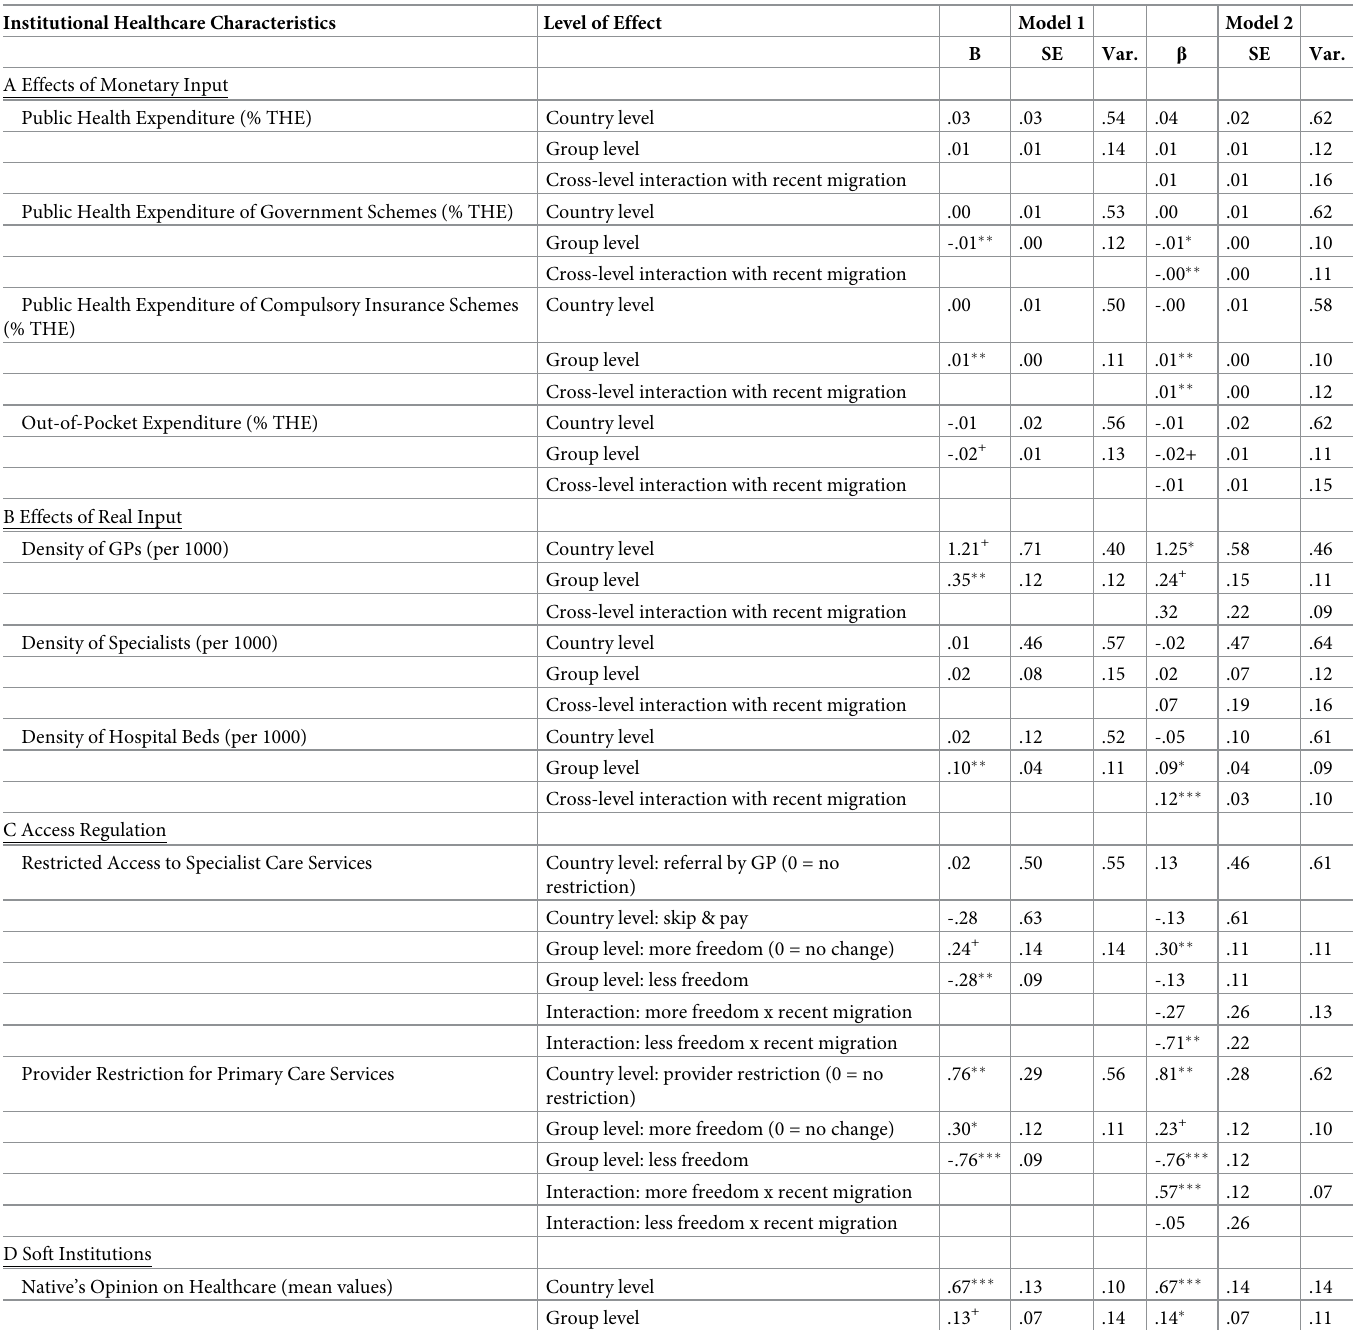
Table 2. Additional effects of other institutional healthcare characteristics on healthcare